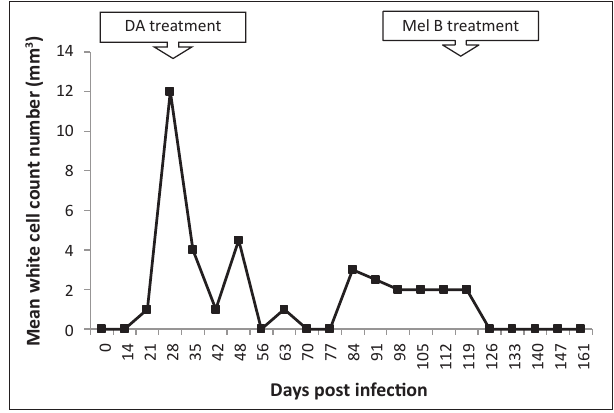
FIGURE 2: White blood cell (WBC) count numbers in the cerebrospinal fluid of T. b. brucei -infected vervet monkeys, showing the point of subcurative treatment with diminazene aceturate (DA) (28 dpi) and curative treatment with melarsoprol (Mel B) (119 dpi).